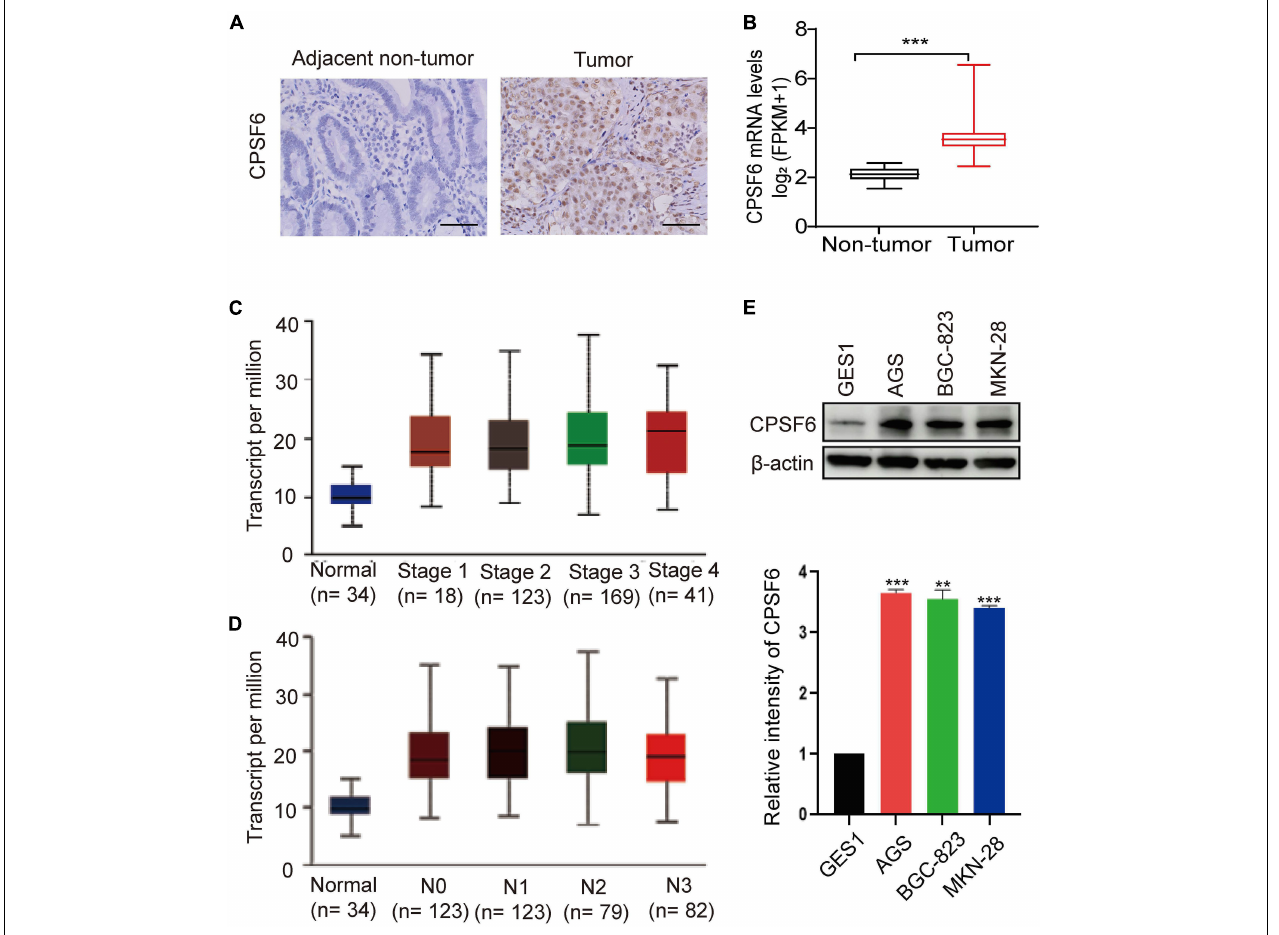
FIGURE 1 | Expression of CPSF6 was upregulated in GC. (A) The IHC staining assay of CPSF6 in GC and adjacent tissues of the tumor (scale bar: 100 µ m). (B) Analysis of CPSF6 mRNA levels of GC ( n = 352) and non-tumor tissues ( n = 32) in TCGA. (C) Expression of CPSF6 in GC based on individual cancer stages in TCGA. (D) Expression of CPSF6 in GC based on nodal metastasis status in TCGA. (E) Western blot assay for detecting CPSF6 expression in different cell lines. **0.001 < p < 0.01; *** p <